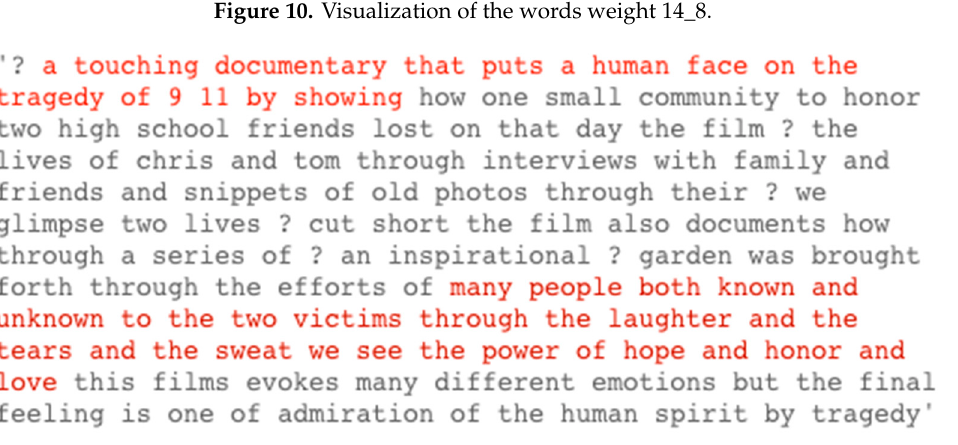
Figure 11. Comment tag diagram numbered 14_8.